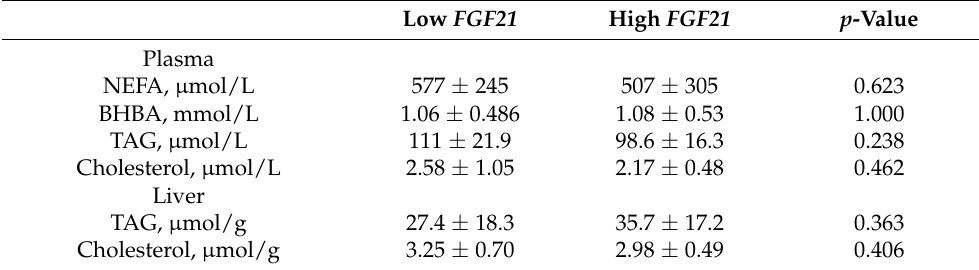
Table 2. Plasma and liver concentrations of metabolic parameters in cows with high and low hepatic FGF21 expression in week 1